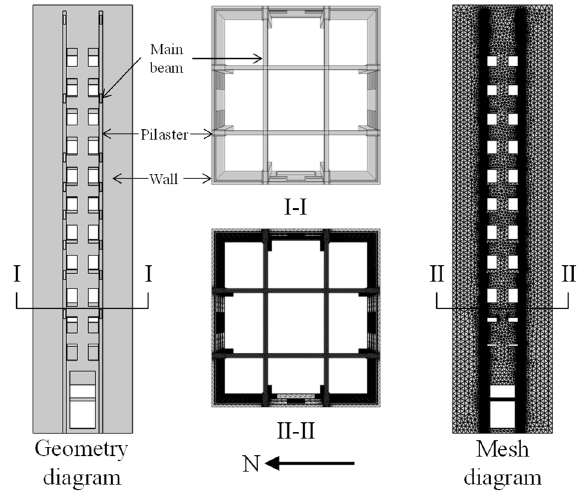
Figure 6. Geometry and mesh diagrams of the